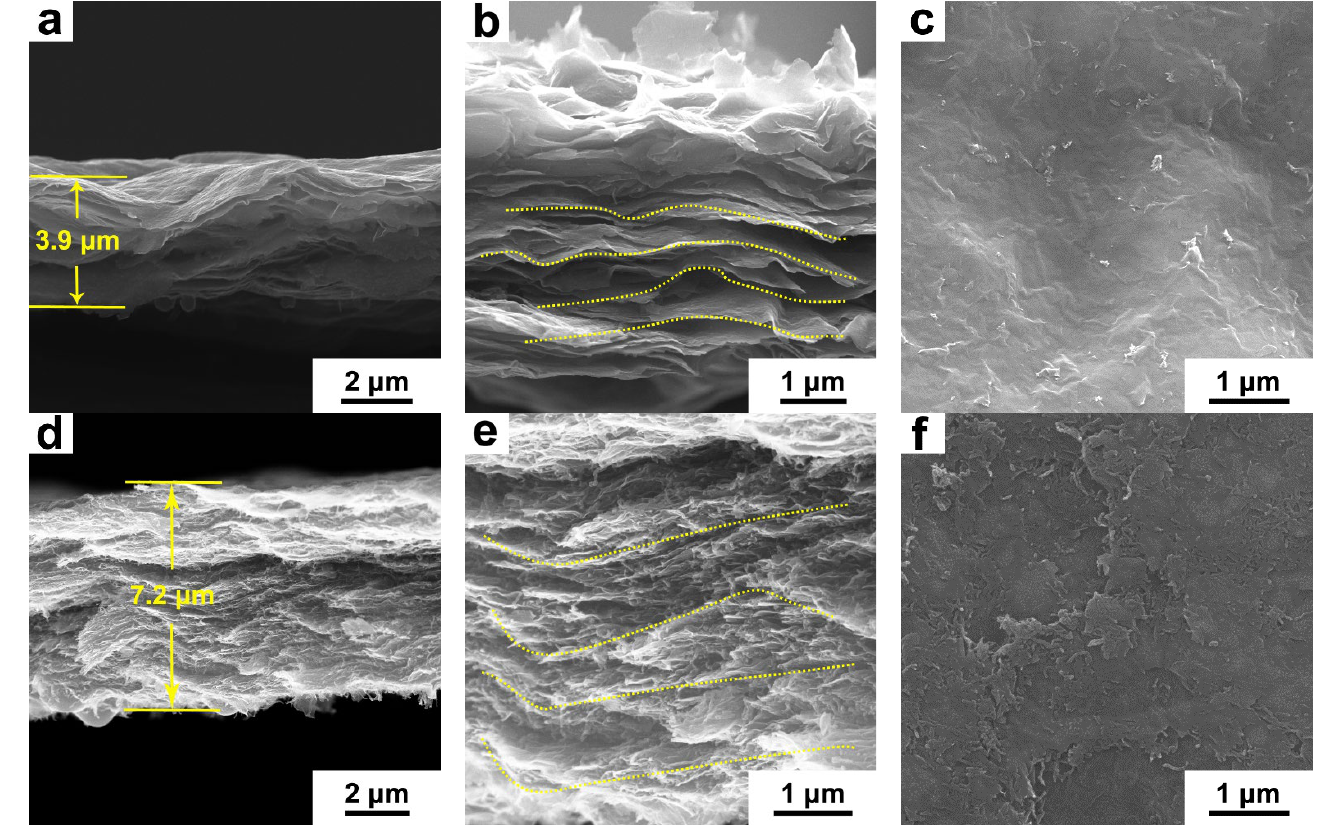
Figure 3. ( a , b , d , e ) Cross-section and ( c , f ) top-view SEM images of the Ti 3 C 2 /T-50C membranes. The average evaporation rate of water, Ti 3 C 2 , T-20C, T-50C and T-80C membranes under one Sun irradiation is 0.42, 1.41, 1.47, 1.55 and 1.50 kg/m 2 ·h, respectively (Figure 4a). The optimized solar evaporation rate is 3.7 times higher than that of pristine water. The dark evaporation rate (natural volatilization) of all these membranes is 0.23 kg/m 2 ·h. Therefore, the net evaporation rate is 1.18, 1.24, 1.32 and 1.27 kg/m 2 ·h, respectively. Hence, the average solar-to-vapor conversion efficiency ( η ) is calculated by Equations (S1)–(S4)